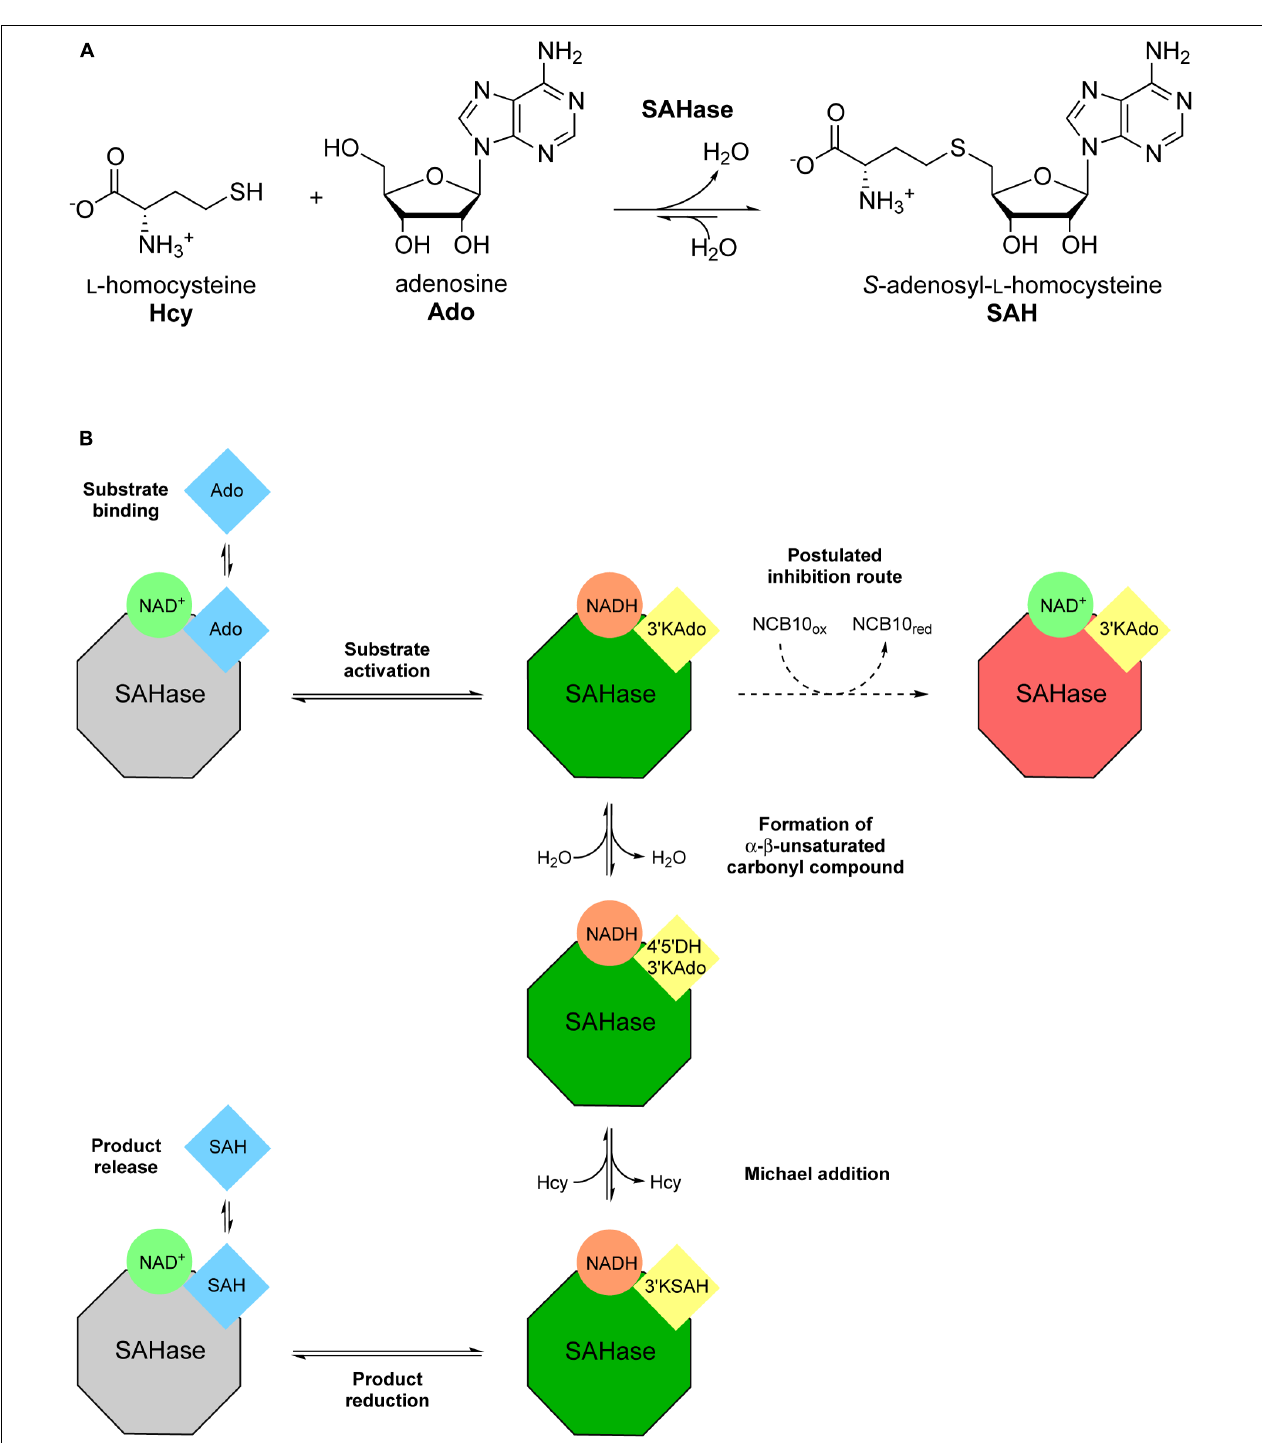
FIGURE 2 | Illustration of the reversible Bradyrhizobium elkanii SAHase-catalyzed S -adenosyl- L -homocysteine (SAH) hydrolysis to adenosine (Ado) and L -homocysteine (Hcy). (A) Reaction scheme with chemical structures of substrates and products. (B) Schematic depiction of the catalytic cycle and the postulated inhibition mechanism. Color coding highlights the redox state of the cofactor (green circles: oxidized form; orange circles: reduced form) and the substrate/intermediate/product (blue squares: reduced C3 (cid:48) ; yellow squares: oxidized C3 (cid:48) ) as well as the state of the enzyme (gray octagons: not activated; green octagons: activated; red octagons: inhibited). Intermediate names (in yellow squares) were abbreviated as follows: 3 (cid:48) -ketoadenosine, 3 (cid:48) KAdo; 4 (cid:48) ,5 (cid:48) -dehydro-3 (cid:48) -ketoadenosine, 4 (cid:48) 5 (cid:48) DH3 (cid:48) KAdo; 3 (cid:48) keto- S -adenosyl- L -homocysteine, 3 (cid:48) KSAH. Bold annotations beside arrows describe the respective stage of the catalytic cycle in the direction of SAH